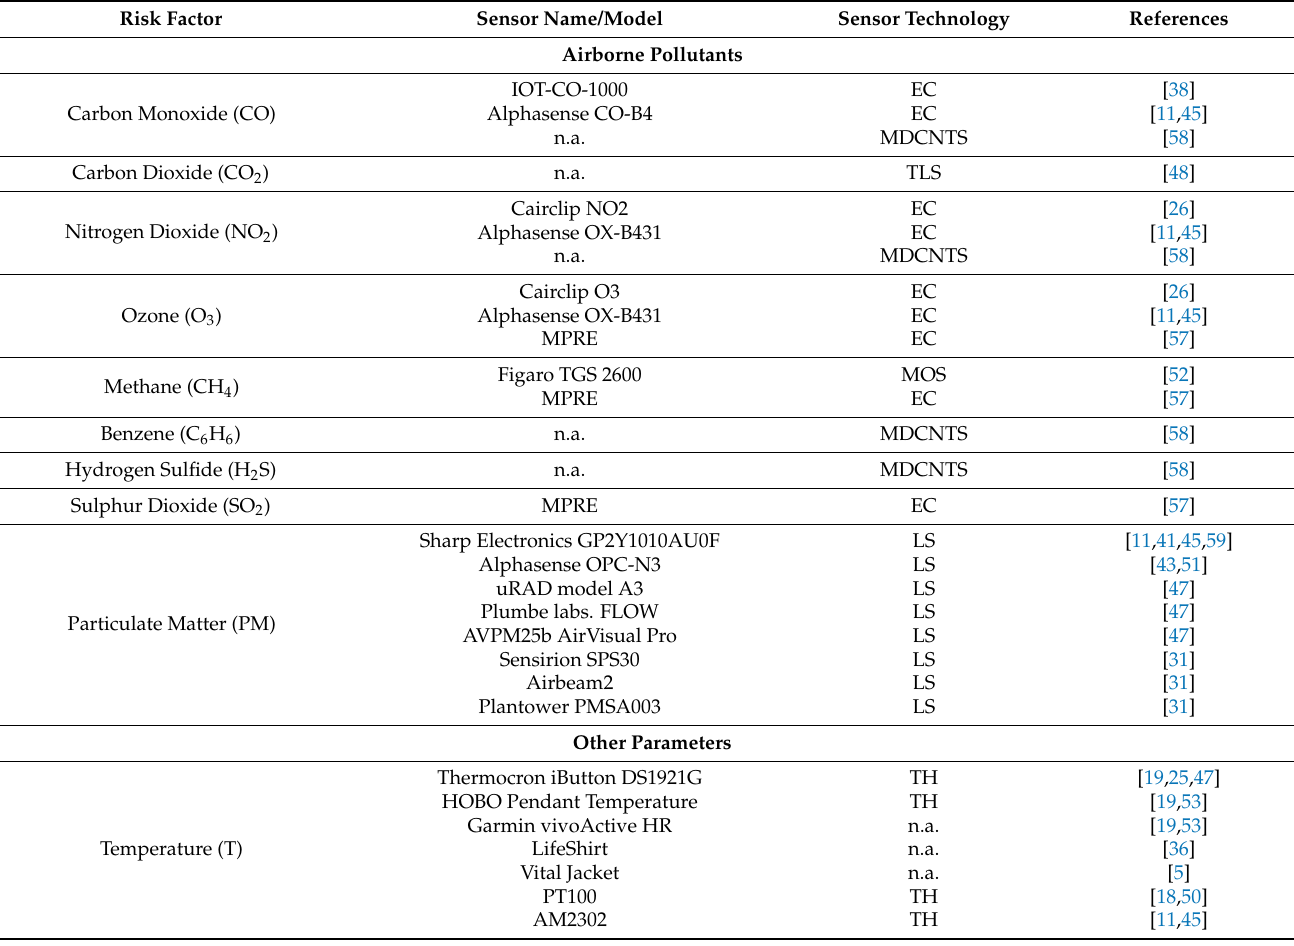
Table 2. Parameters investigated as occupational-risk factors, sensors used for measurement and assessment of these risk factors, and relative